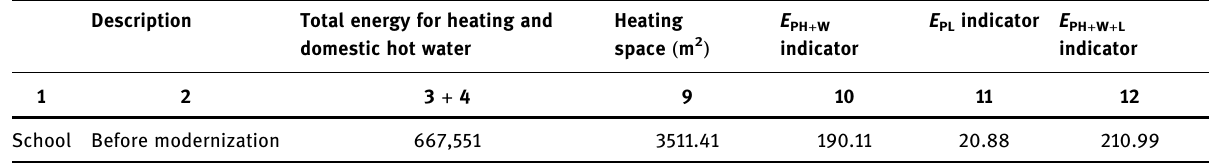
Table 2: Factors: E PH + W , E PL , and E PH + W + L ( kW h/m 2 )